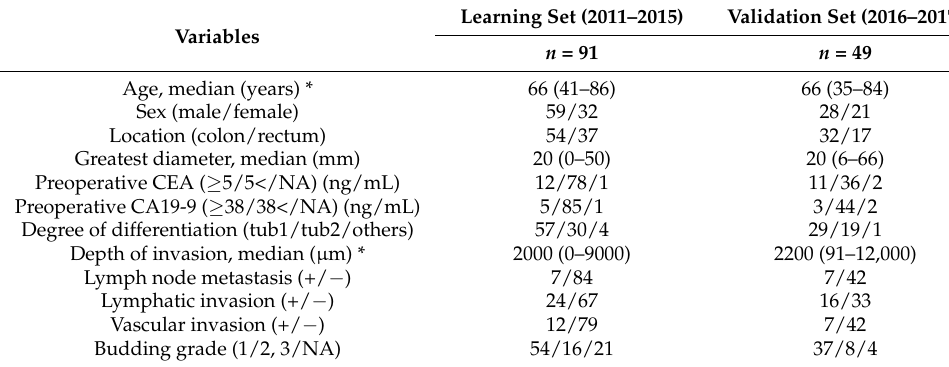
Table 1. Clinicopathological feature.